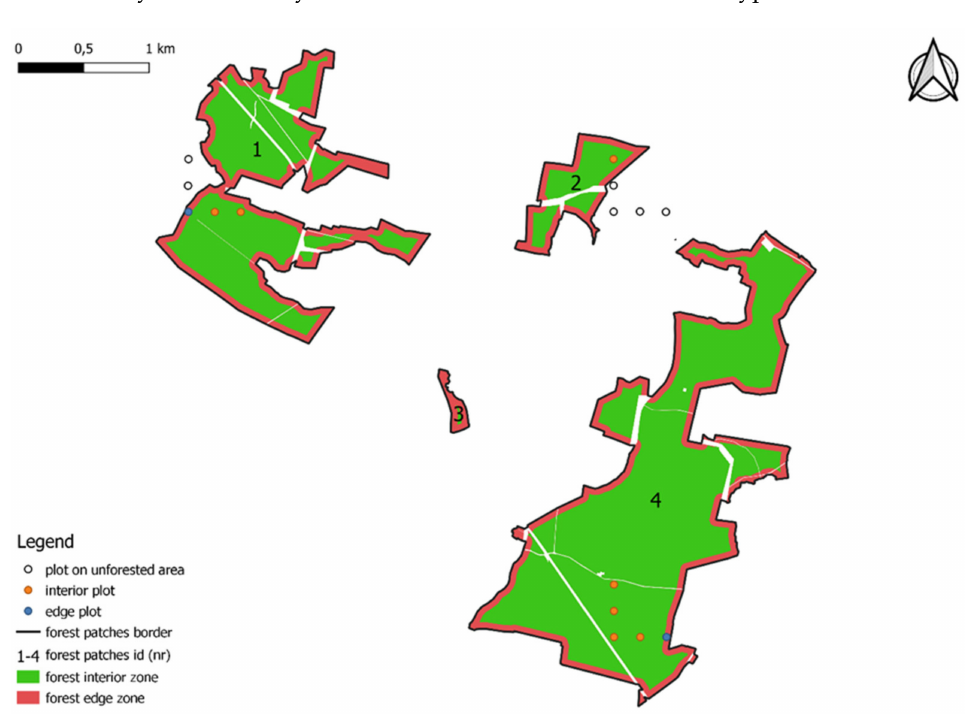
Figure 2. Scheme of generalization of forest fragments into forest patches (4 forest patches were created from 30 forest fragments (see Figure 1)), differentiation of zones of forest patches (edge, interior), and evaluation of NFI plots